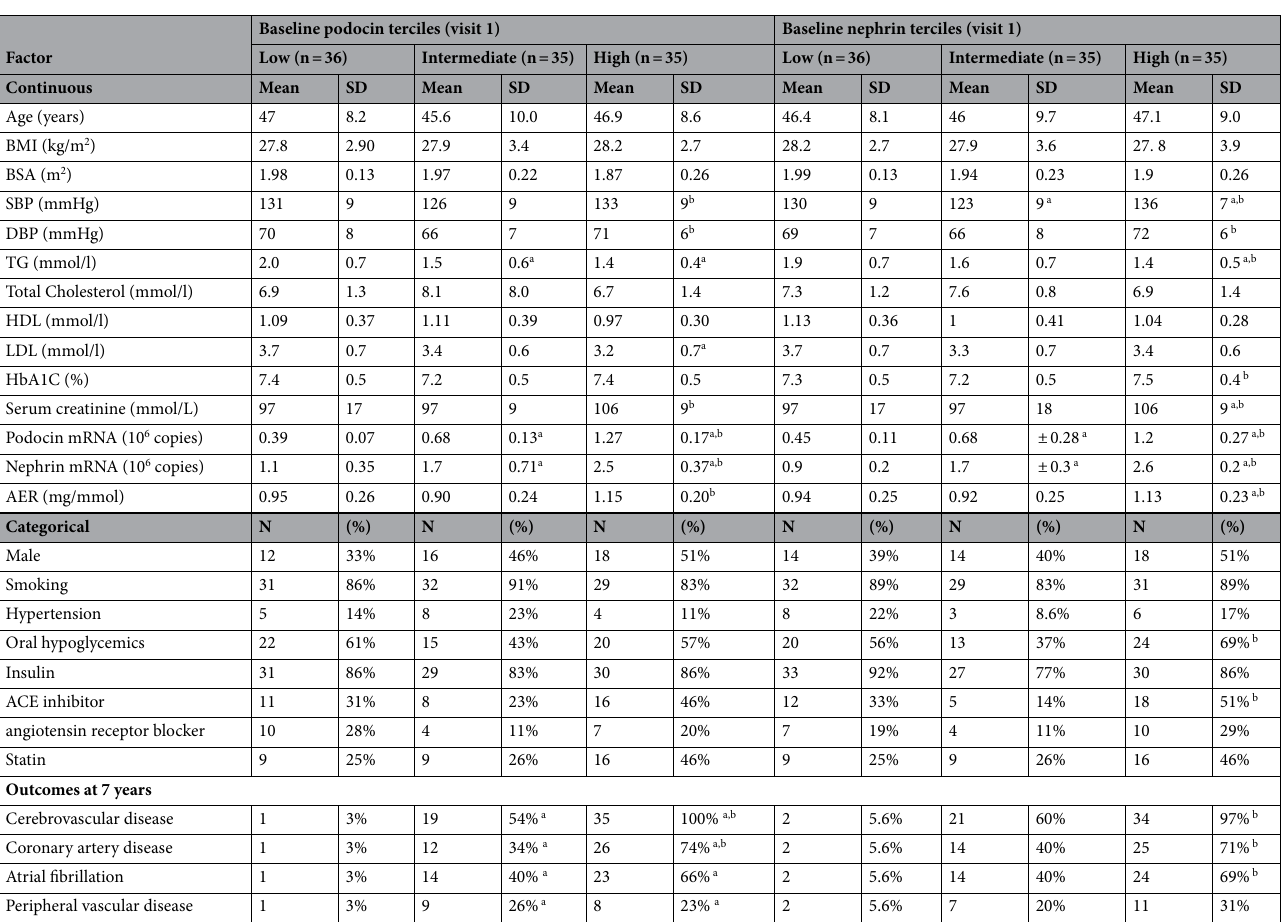
Table 1. Comparisons of subject characteristics, clinical and laboratory data for baseline podocyturia marker sub-groups. a p < 0.05 compared to Low tercile; b p < 0.05 compared to Intermediate